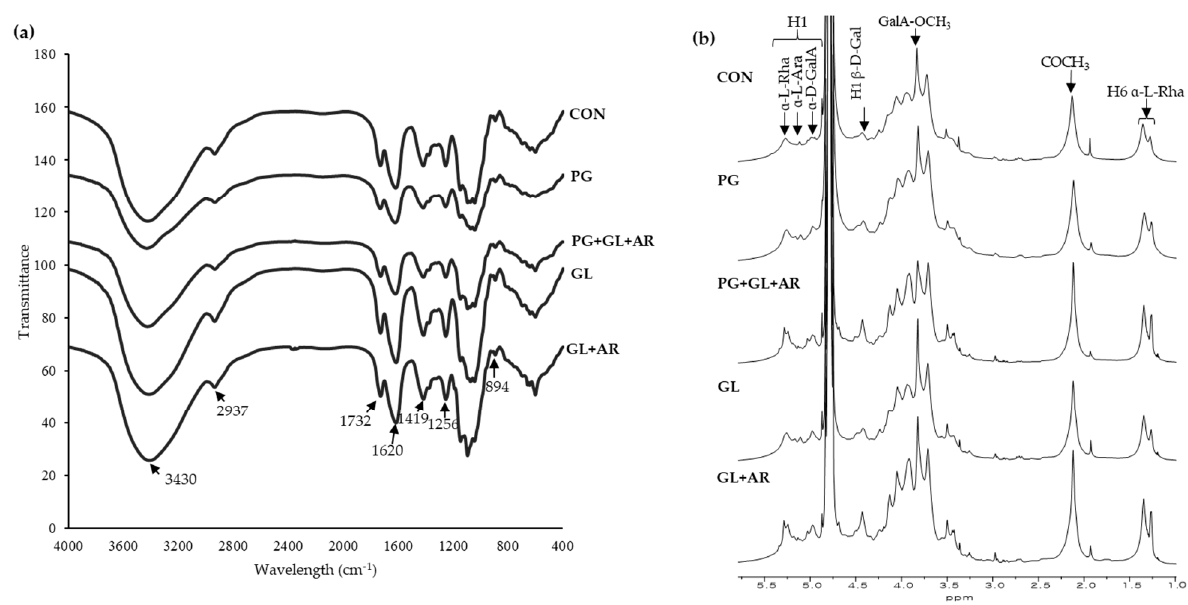
Figure 1. FT-IR ( a ), and 1 H NMR ( b ) spectra of OKP following enzymatic treatments.